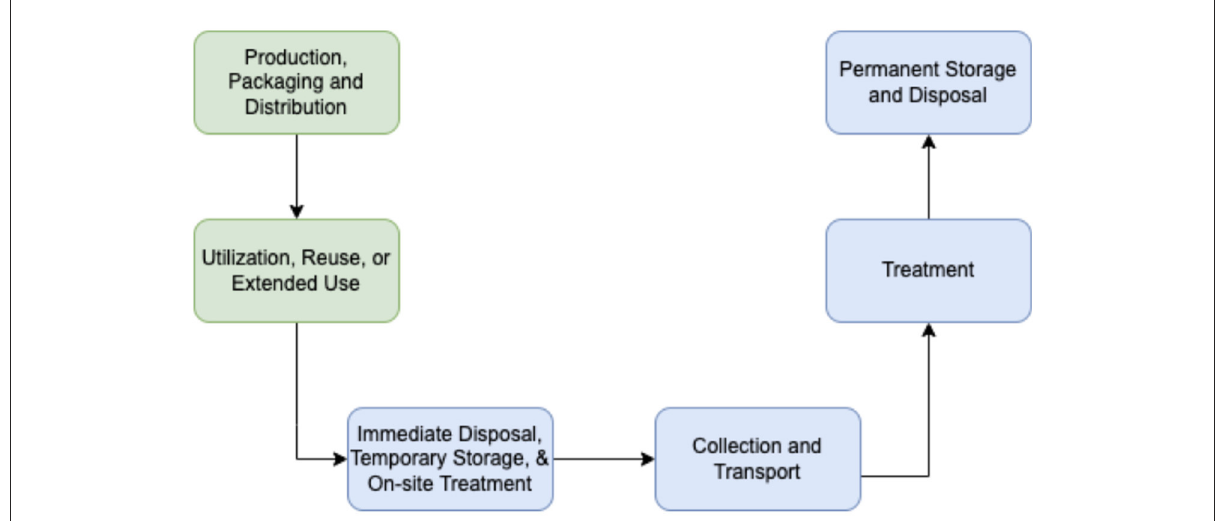
FIGURE1 Cradle-to-end-of-life (CTEOL) framework for analyzing COVID-19 waste management